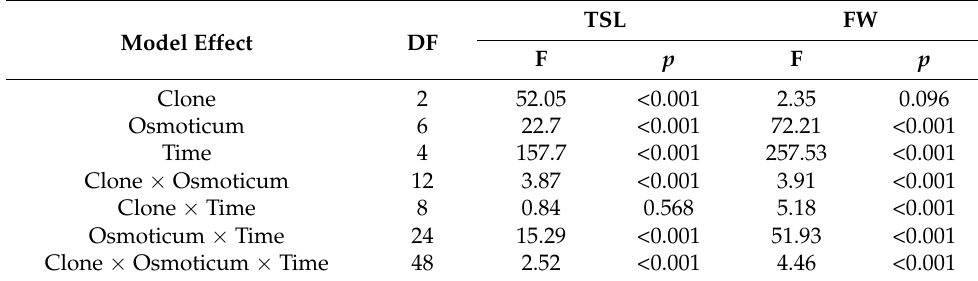
Table 7. ANOVA table for total shoot length TSL and total fresh weight FW for the GEE analysis of R. pseudoacacia (DF—degrees of freedom, F—test statistics; p — p -values).